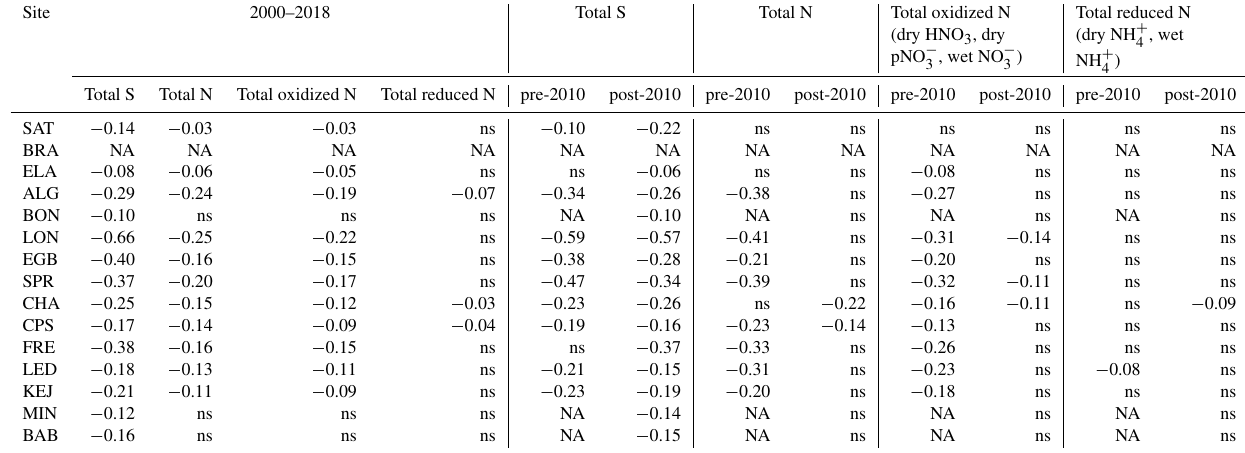
Table 6. Rate of change in annual total (dry + wet) deposition fluxes of N and S (kgN or Sha − 1 yr − 1 ) at CAPMoN sites based on Theil–Sen slopes (statistically significant at p < 0.05). Pre-2010: 2000–2009 period; post-2010: 2010–2018 period; NA: not available due to incomplete data; ns: trend is not statistically significant. Note: total N and reduced N exclude dry deposition of NH 3 and some oxidized nitrogen